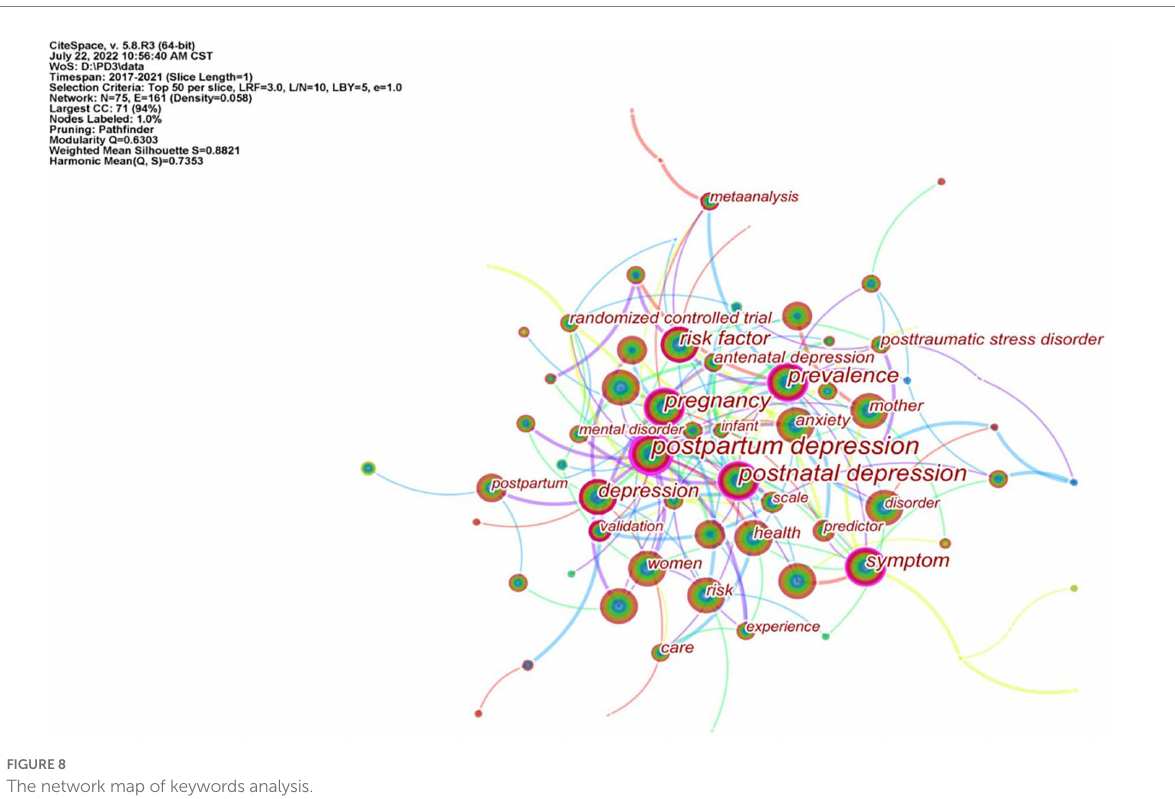
FIGURE 8 The network map of keywords analysis.